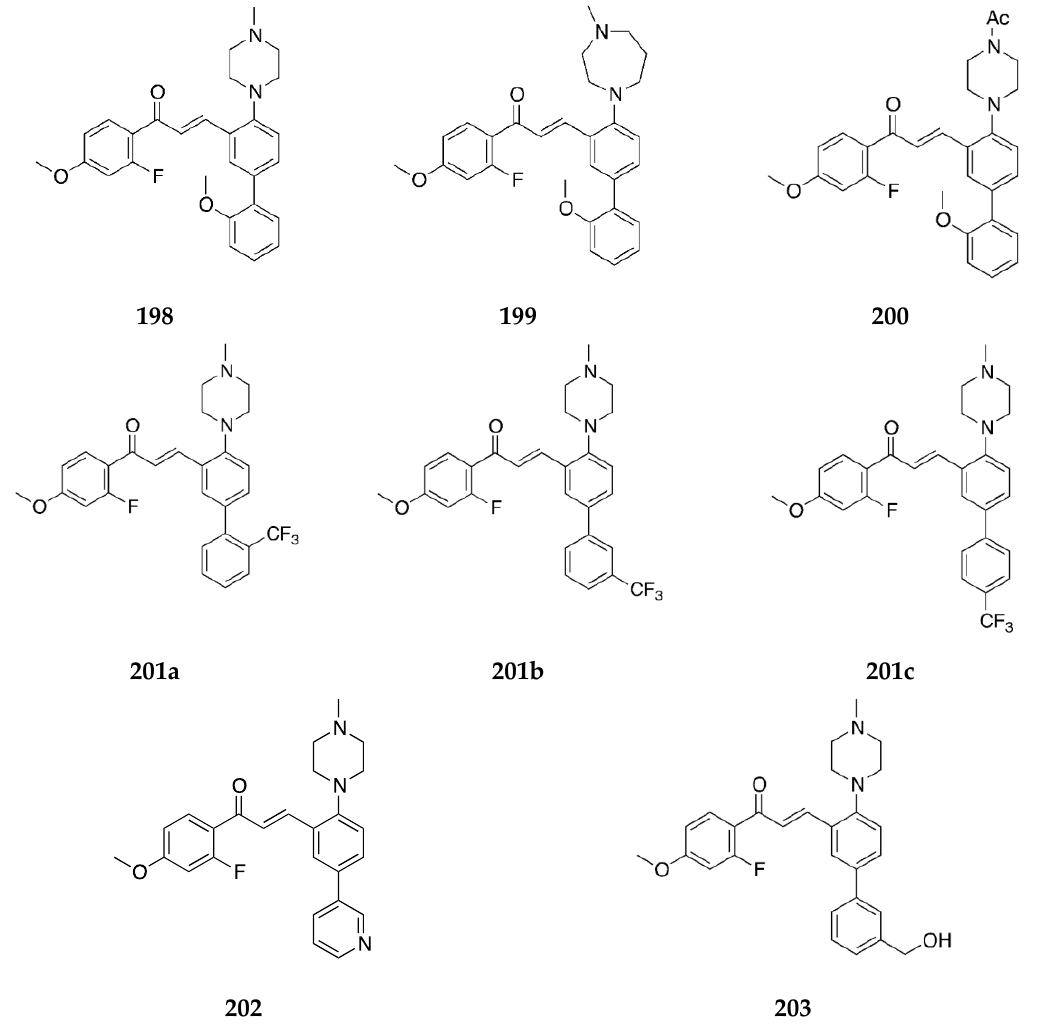
Figure 65. Chemical structures of N, N -dialkylated 2′-aminochalcone derivatives. The antibacterial activities for 198 – 203 against S. aureus ATCC33591 (resistant to methicillin), E. faecium 17501 (vancomycin-resistant clinical isolate), and E. faecium ATCC29212 are shown in Table 29. Table 29. Antibacterial activity of 198 – 203 against S. aureus ATCC33591 (resistant to methicillin), E. faecium 17501 (vancomycin-resistant clinical isolate), and E. faecium ATCC29212: activity is expressed as MIC values in µM.